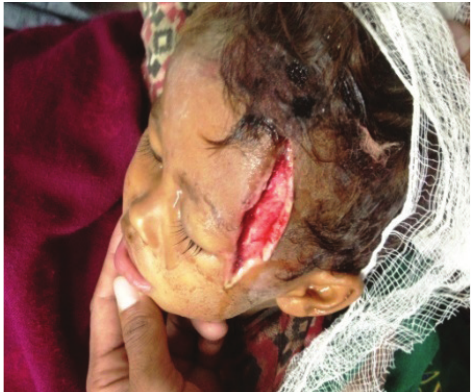
Figure 3: Two year child with laceration and depressed fracture.